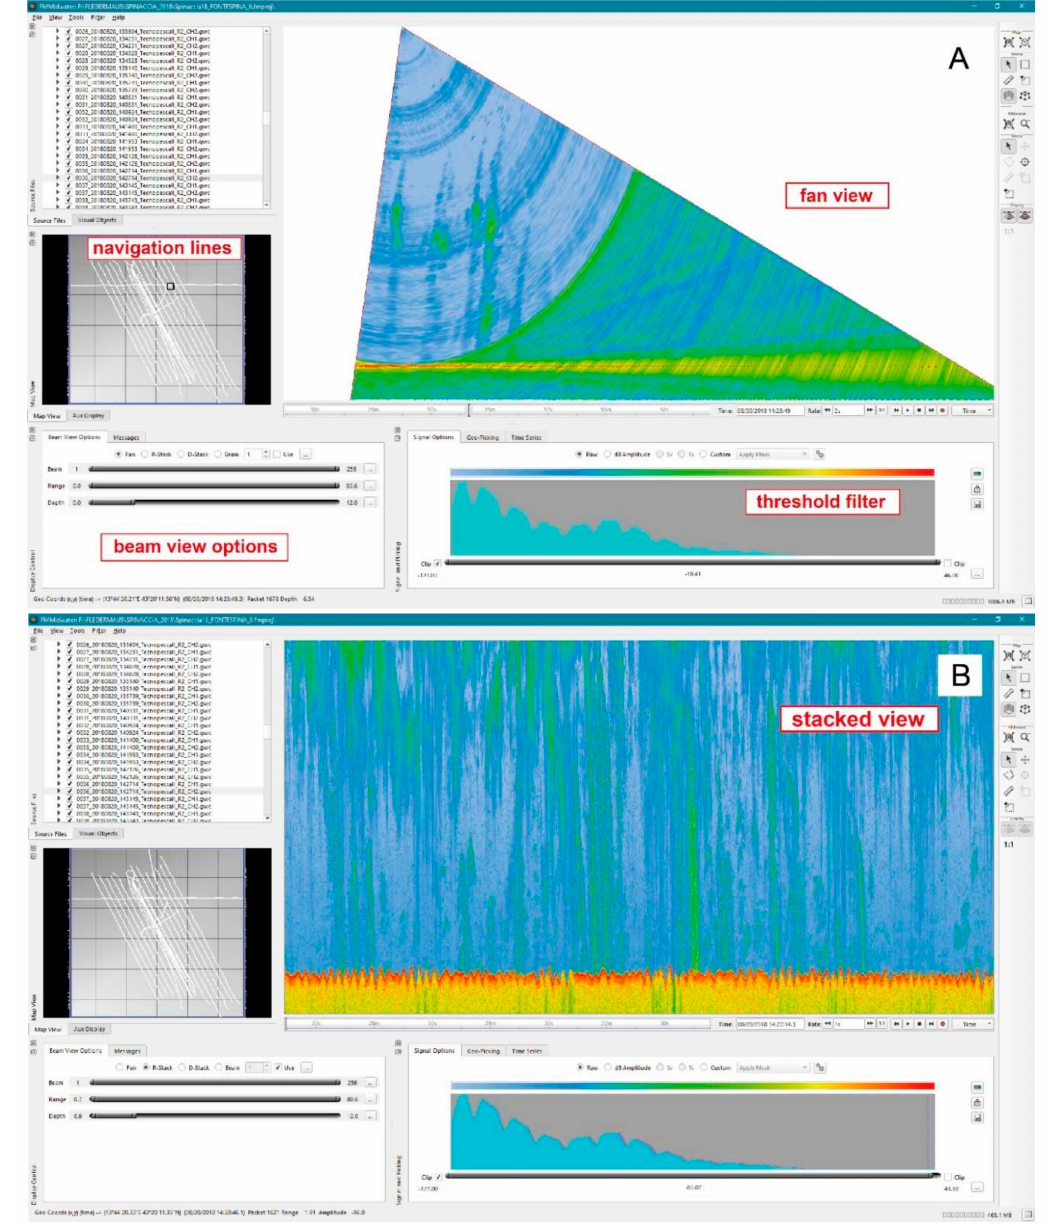
Figure 2. Acoustic anomalies associated with natural seeps observed in the FMMidwater Fan View ( A ) and in Stacked View ( B ). The gas plumes rising sub-vertically from the seafloor are visible without applying a